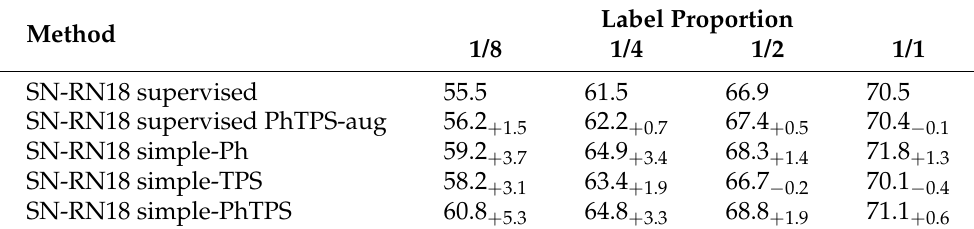
Table 2. Ablation experiments on half-resolution Cityscapes val (mIoU/%) with SwiftNet-RN18. Subscripts denote the difference from the supervised baseline. The label “supervised PhTPS-aug” denotes supervised training where half of each mini-batch is perturbed with PhTPS. The bottom three rows compare PhTPS with Ph (only photometric) and TPS (only geometric) under simple one-way consistency. We present means of experiments on 5 different dataset splits. Numerical subscripts are differences with respect to the supervised